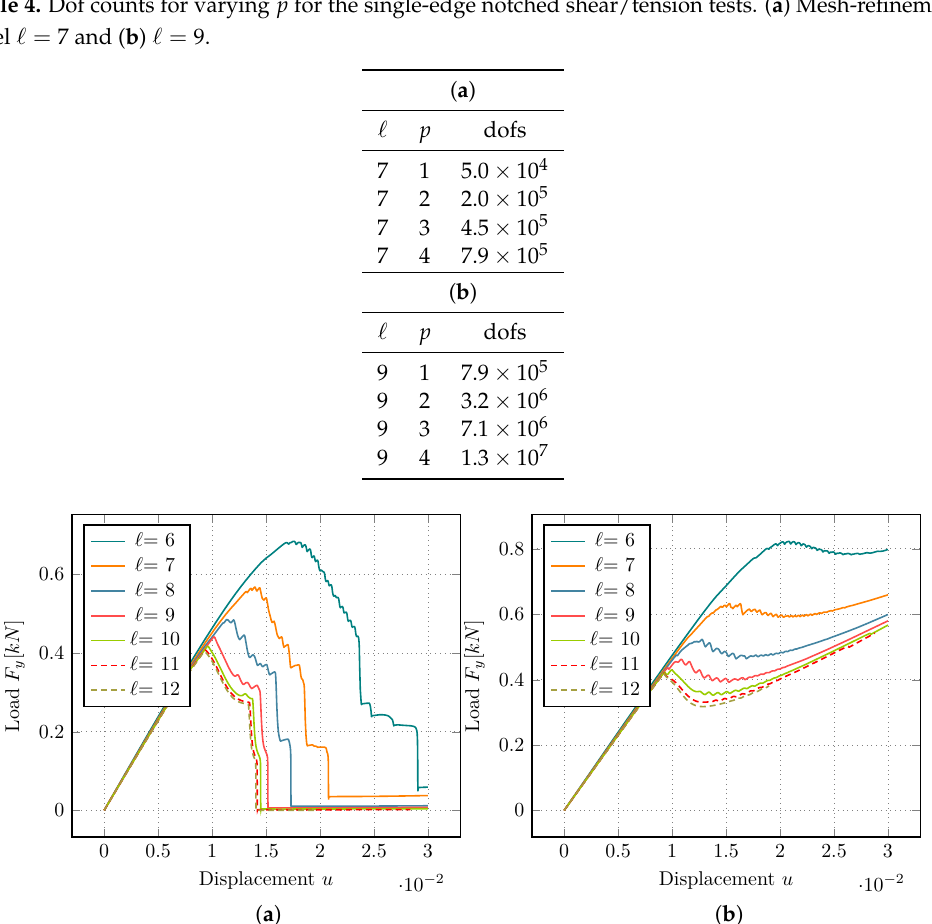
Figure 4. Refinement studies for the single-edge notched shear test. ( a ) Isotropic case (no splitting). ( b ) Miehe splitting. All other parameters are fixed. In particular, ε is set to ε = 4 × 10 − 3